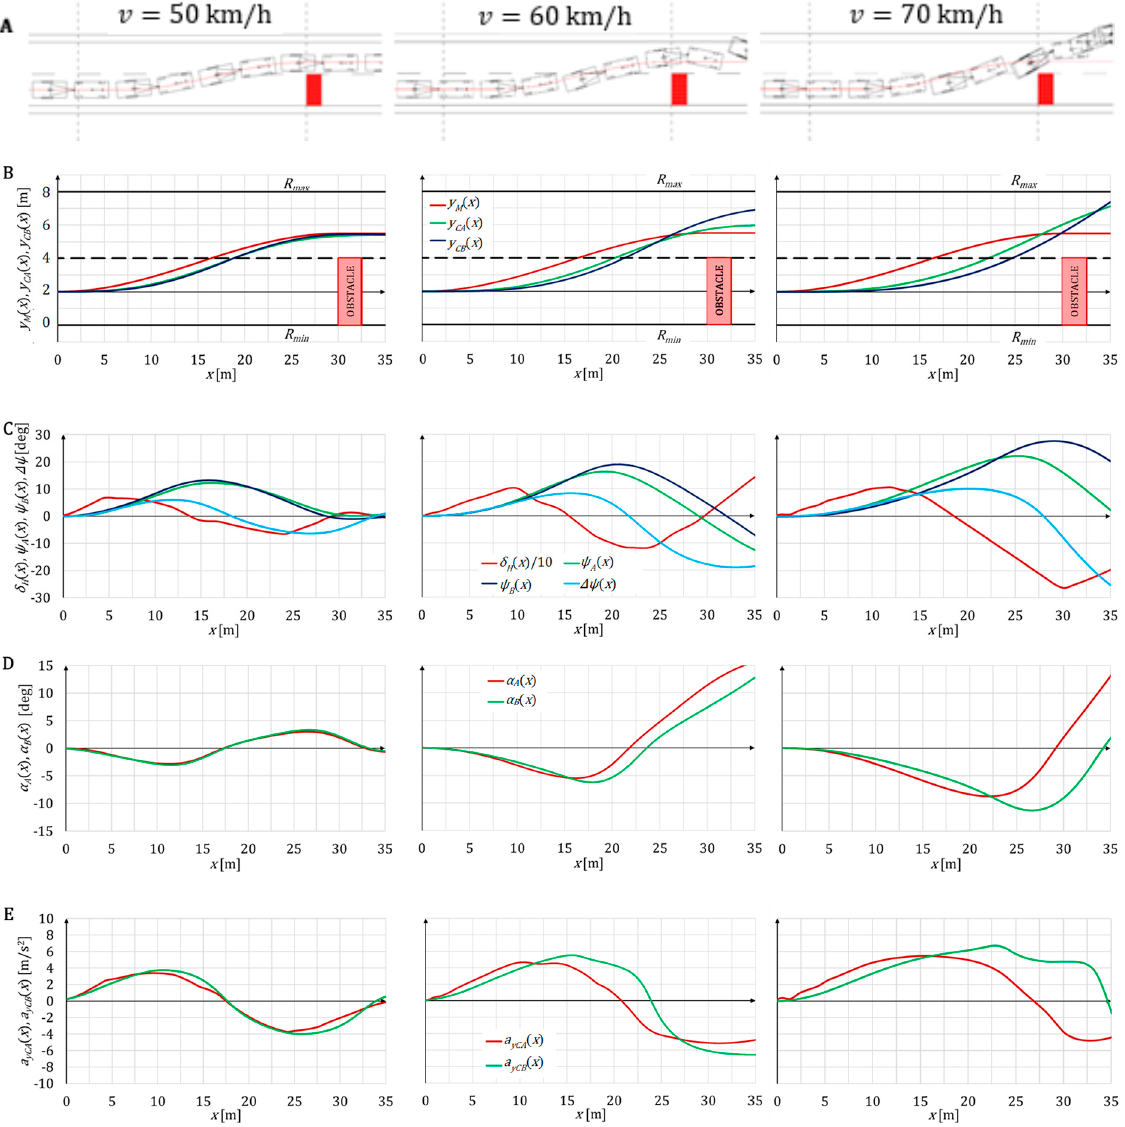
Figure 18. Obstacle avoidance simulation results obtained for the cosine method, L a = 6 m, y W = 0.5 m, dry road surface and different driving speeds (individual columns): ( A ) CT unit’s motion animation; ( B ) path planning trajectory y M ( x ) and vehicles center of mass trajectory y Cs ( x ) ; ( C ) steering wheel angle δ H ( x ) , yaw angle ψ A ( x ) , trailer drawbar turning angle ∆ ψ ( x ) ; ( D ) tire sideslip angles for the rear axle of vehicles α s ( x ) ; ( E ) lateral acceleration of vehicles center of mass a yCs ( x ) .